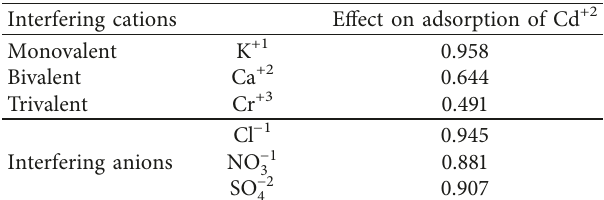
Table 5: Effect of interfering cations and anions on % adsorption of